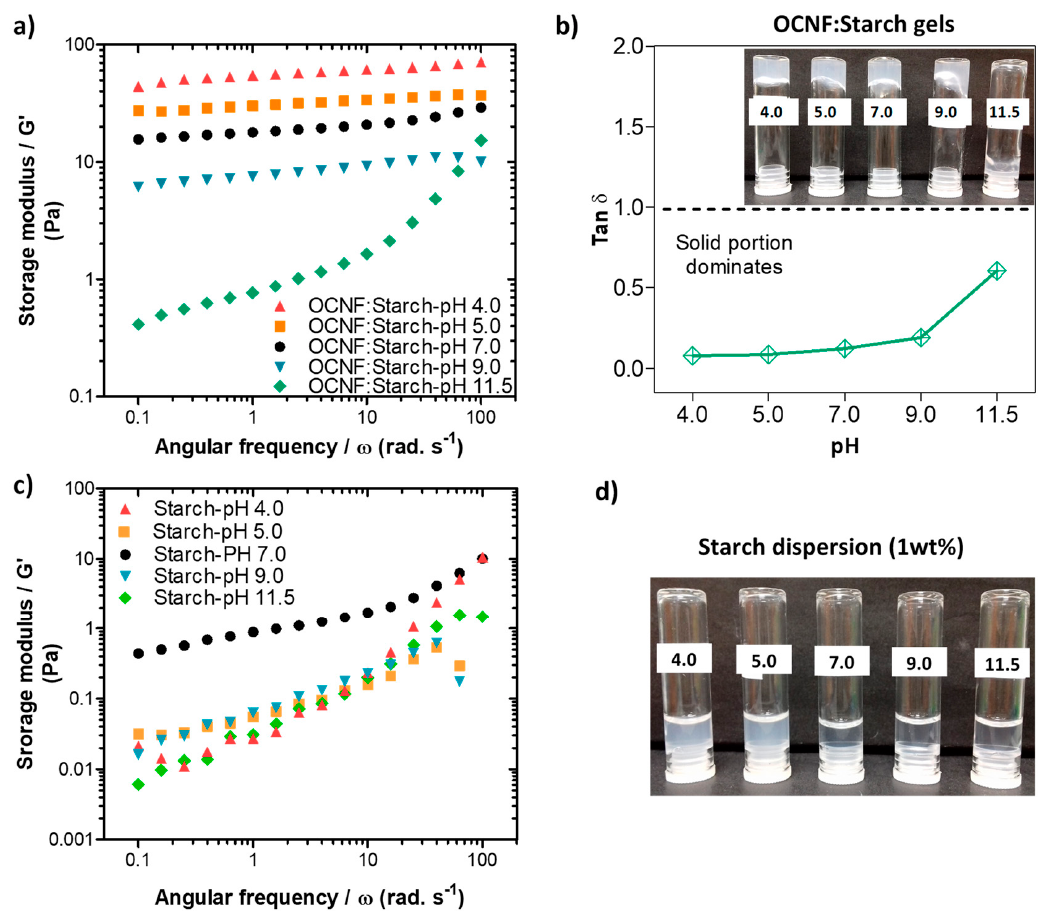
Figure 6. ( a ) Oscillatory frequency sweeps and ( b ) tan δ data for the OCNF:starch (1:1 wt%) blends at different pH (4, 5, 7, 9, and 11.5). Inset in (b) is a photograph of the samples labelled by their pH. ( c ) Frequency sweep curves and ( d ) photograph of the control starch (1 wt%) dispersions produced at the various pH values.